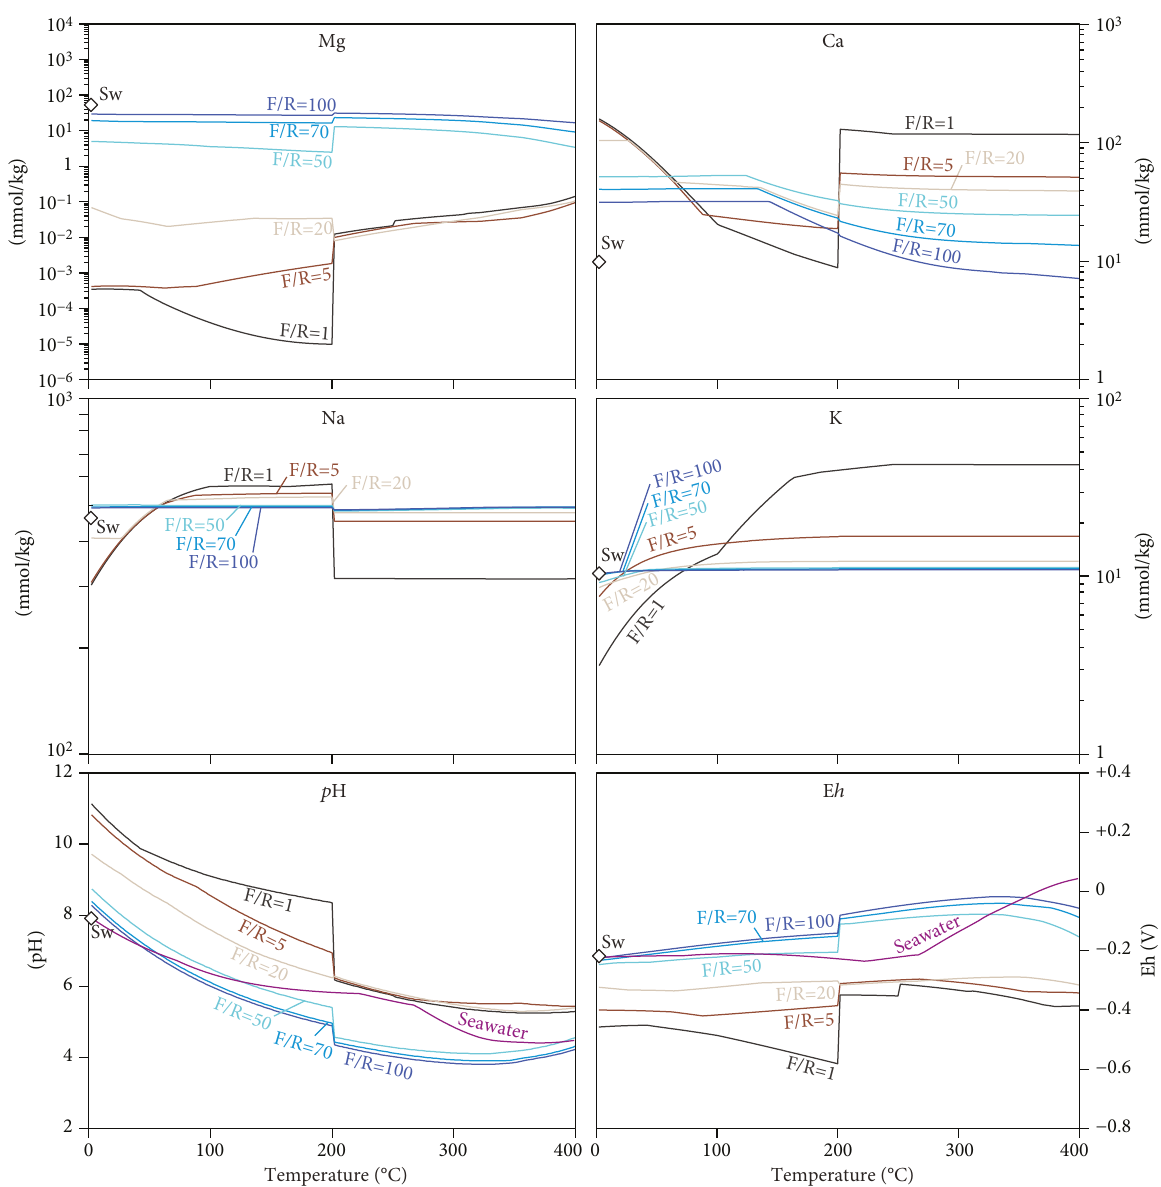
Figure 3: Simulated fl uid composition in total dissolved Mg, Ca, Na, and K (in mmol/kg) with pH and Eh following seawater-basalt interaction from 2 to 400 ° C, 500 bars, and variable fl uid/rock (F/R) mass ratios. White diamonds represent the composition of seawater at 2 ° C (see Table 1). The purple curves represent the pH and Eh evolutions of heated seawater